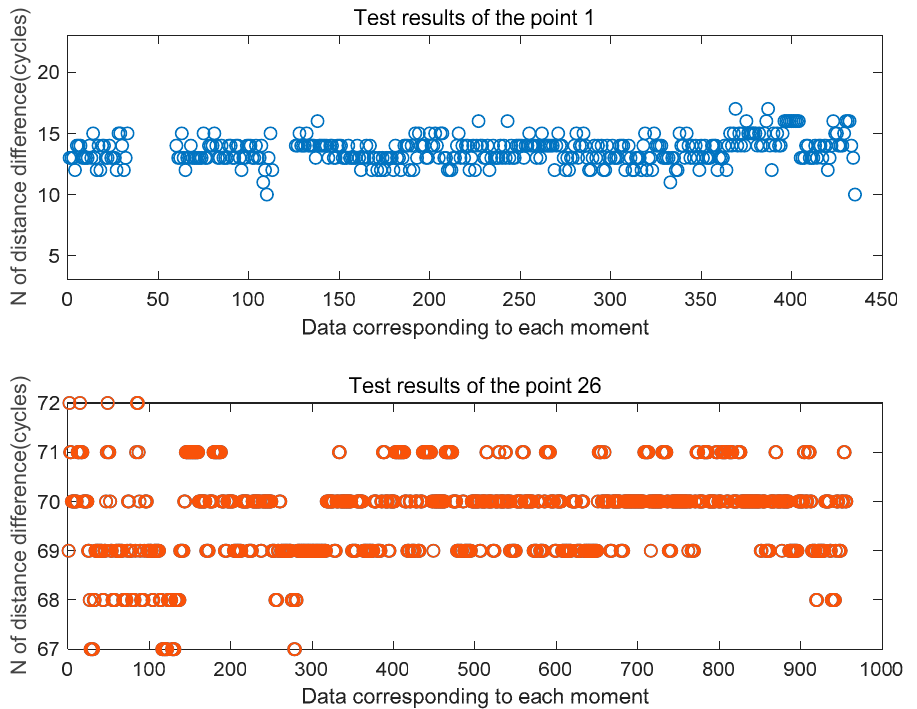
Figure 14. Estimated distance di ff erence N at the three feature points in the first set of tests.